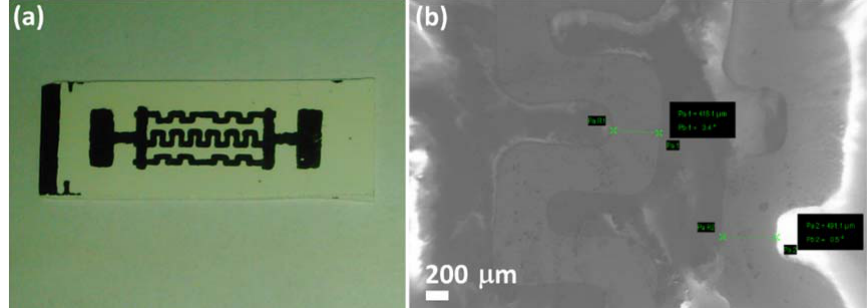
Figure 6. (a) Optical digital image; and (b) SEM image of microheaters on ceramic substrate with nickel